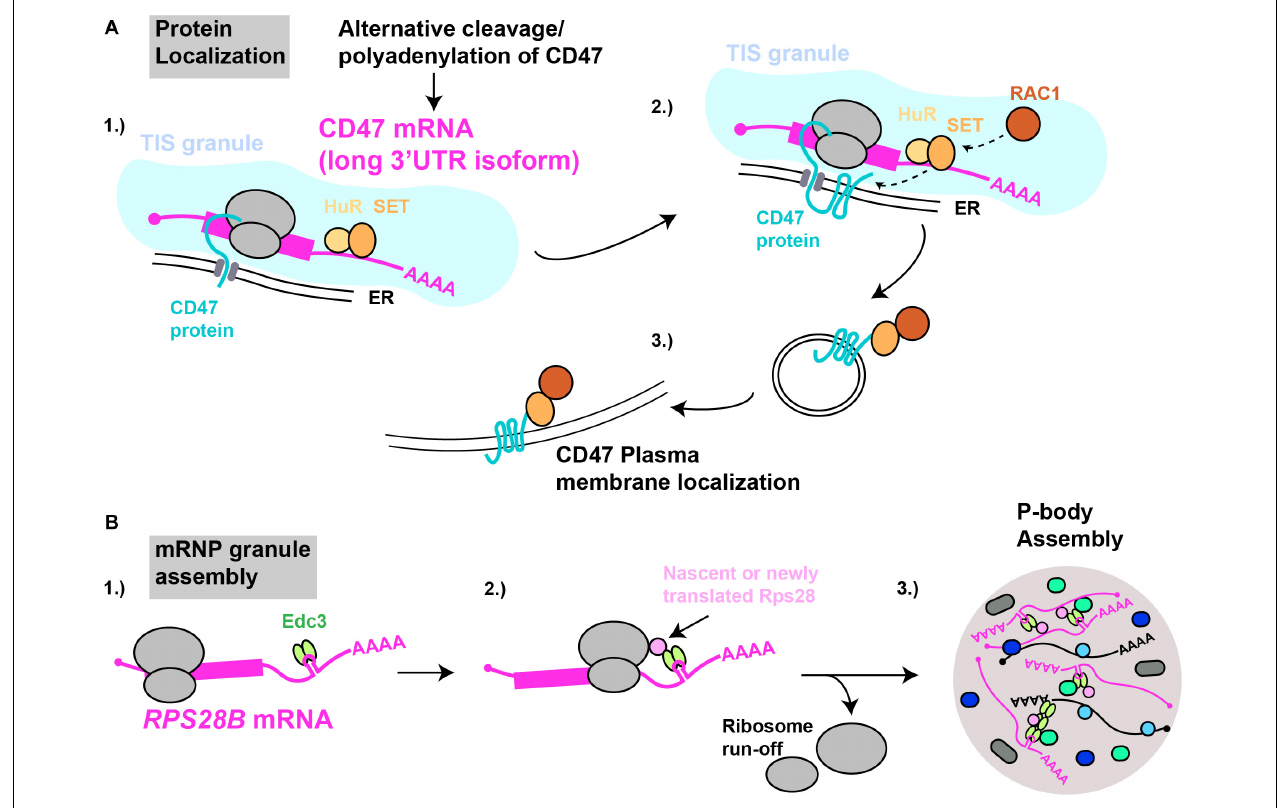
FIGURE 4 | mRNAs as cytoplasmic RNA scaffolds. (A) Protein localization: (1) The CD47-LU mRNA 3 (cid:48) UTR recruits HuR and SET. (2) Within TIS11B-ER membrane compartments (TIS granules), nascently translated CD47’s interaction with SET is facilitated. (3) Recruitment of RAC1 by SET results in subsequent translocation of CD47 to the plasma membrane. (B) mRNP granule assembly: (1) The RPS28B 3 (cid:48) UTR is presumed to recruit Edc3 prior to its subsequent interaction, (2) with either nascently or newly translated Rps28. (3) Since translating mRNAs are excluded from mRNP granules, ribosome run-off is likely required for an RPS28B -Edc3-Rps28 RNP complex to help nucleate yeast P-body